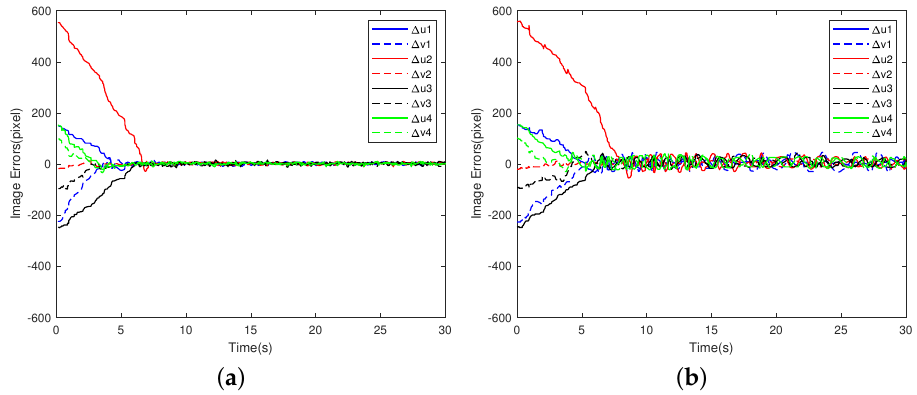
Figure 15. Image errors of comparative simulations with time-varying external disturbances for the 6-DOF robot manipulator. ( a ) Image errors in Case 3 with time-varying external disturbances. ( b ) Image errors in Case 4 with time-varying external disturbances.